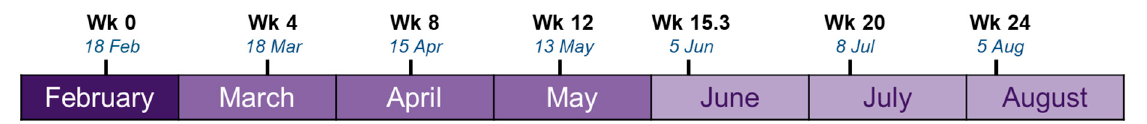
Figure 3. Timeline for coupon removal.